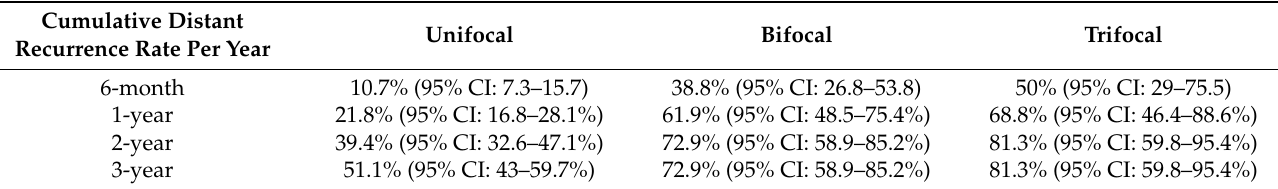
Table 2. Cumulative distant recurrence rate per